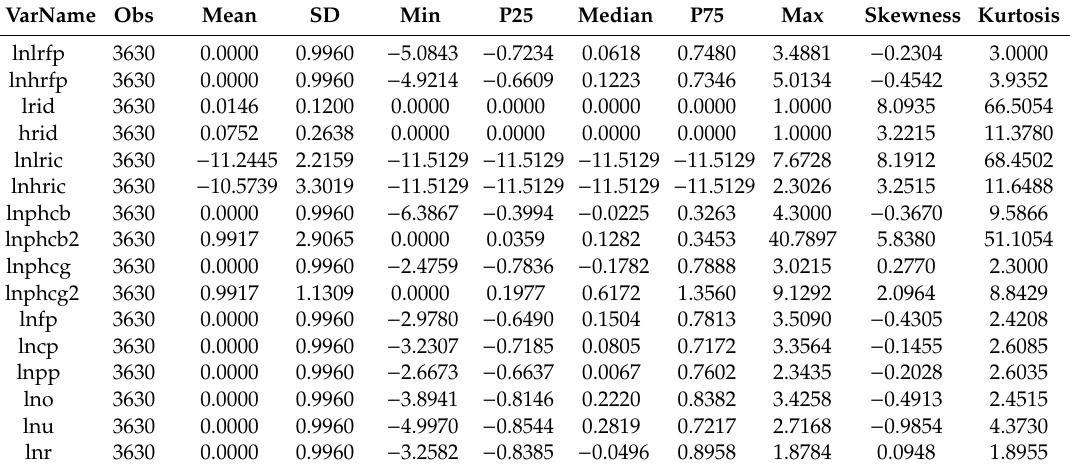
Table 3. Summary